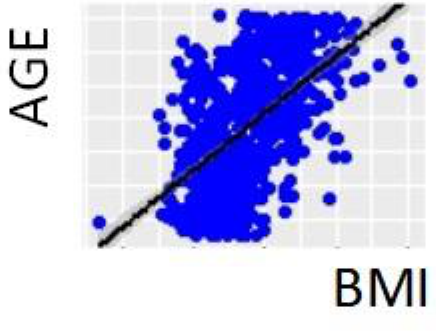
Figure 1. Box plot of age ( a ), and BMI ( b ), according to BMI category. Healthcare 2022 , 10 , x. 5 of 12 Figure 2. Box plot of age ( a ), and BMI ( b ), according to race.